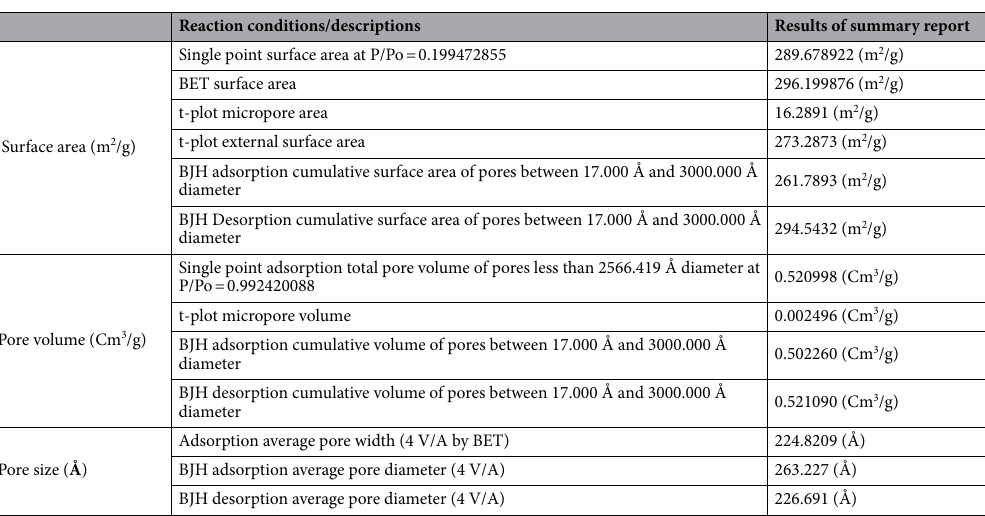
Table 1. BET/BJH analysis summary.